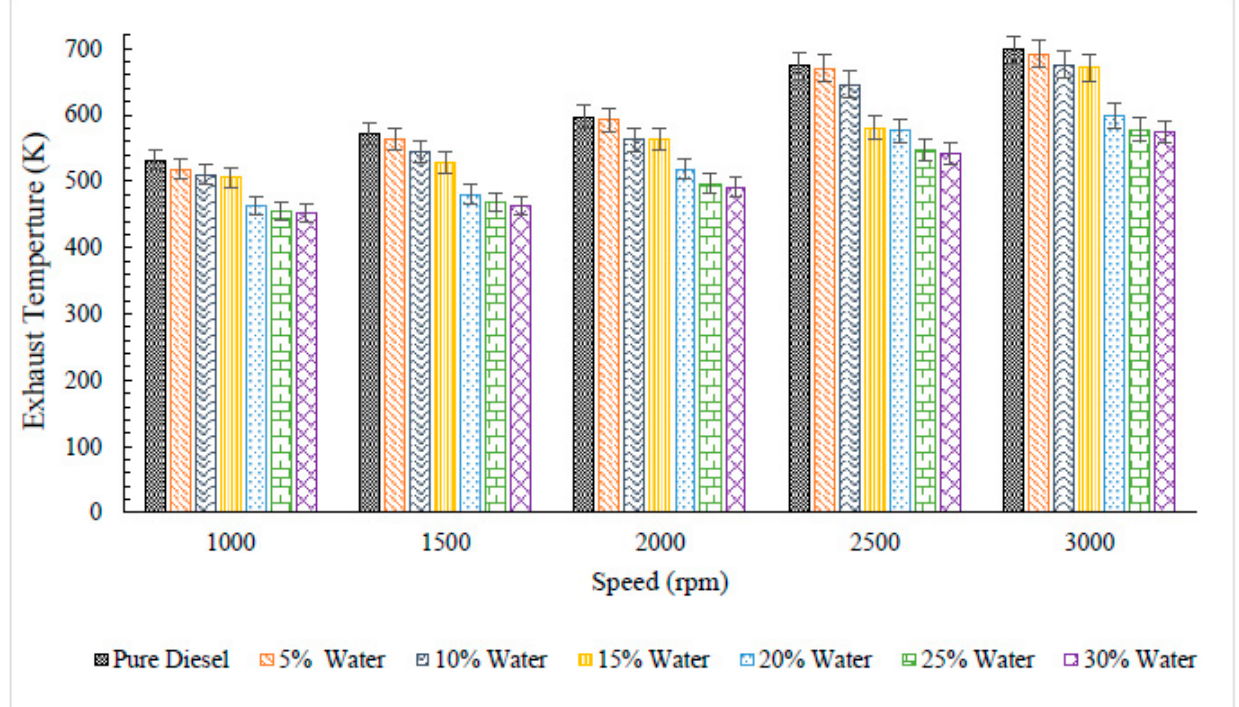
Figure 2. Effect of water-in-diesel emulsion fuel on exhaust gas temperature of a diesel engine at different engine speed.